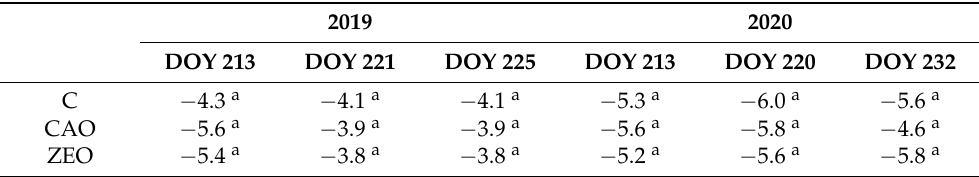
Table 3. Midday stem water potential ( Ψ stem, bar) during the 2019 and 2020 seasons. Measurements were taken on one mature basal leaf per vine. Different letters within a column indicate significant differences as calculated by the Tukey statistical analysis test ( p ≤ 0.05).